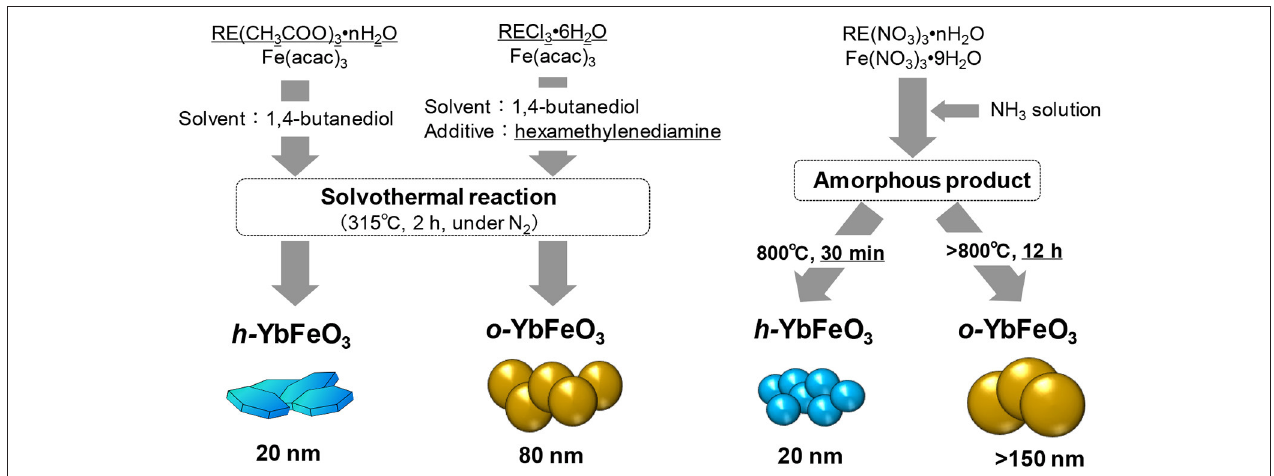
FIGURE 2 | Flow chart showing crystal structure control utilizing the solvothermal method (Left) and coprecipitation method (Right) .